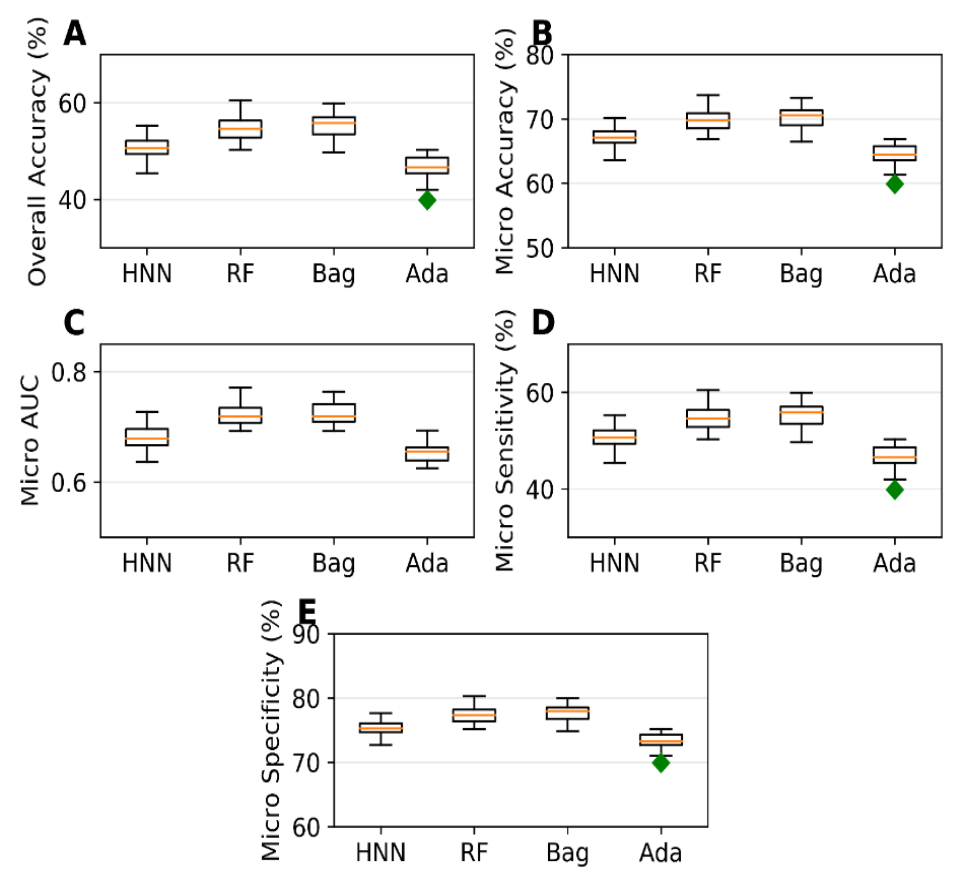
Figure 2. ( A ) Overall accuracy, ( B ) micro accuracy, ( C ) micro AUC, ( D ) micro sensitivity, and ( E ) micro specificity for the dataset II as given by the multiclass classification models developed based on HNN, RF, Bagging, and AdaBoost methods.